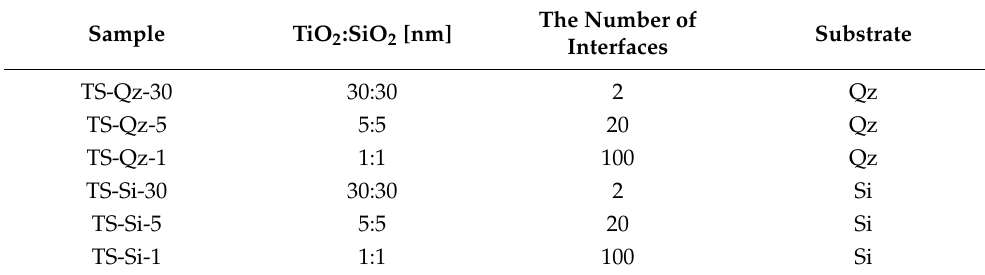
Table 1. Experimental parameters of the TiO 2 /SiO 2 samples.